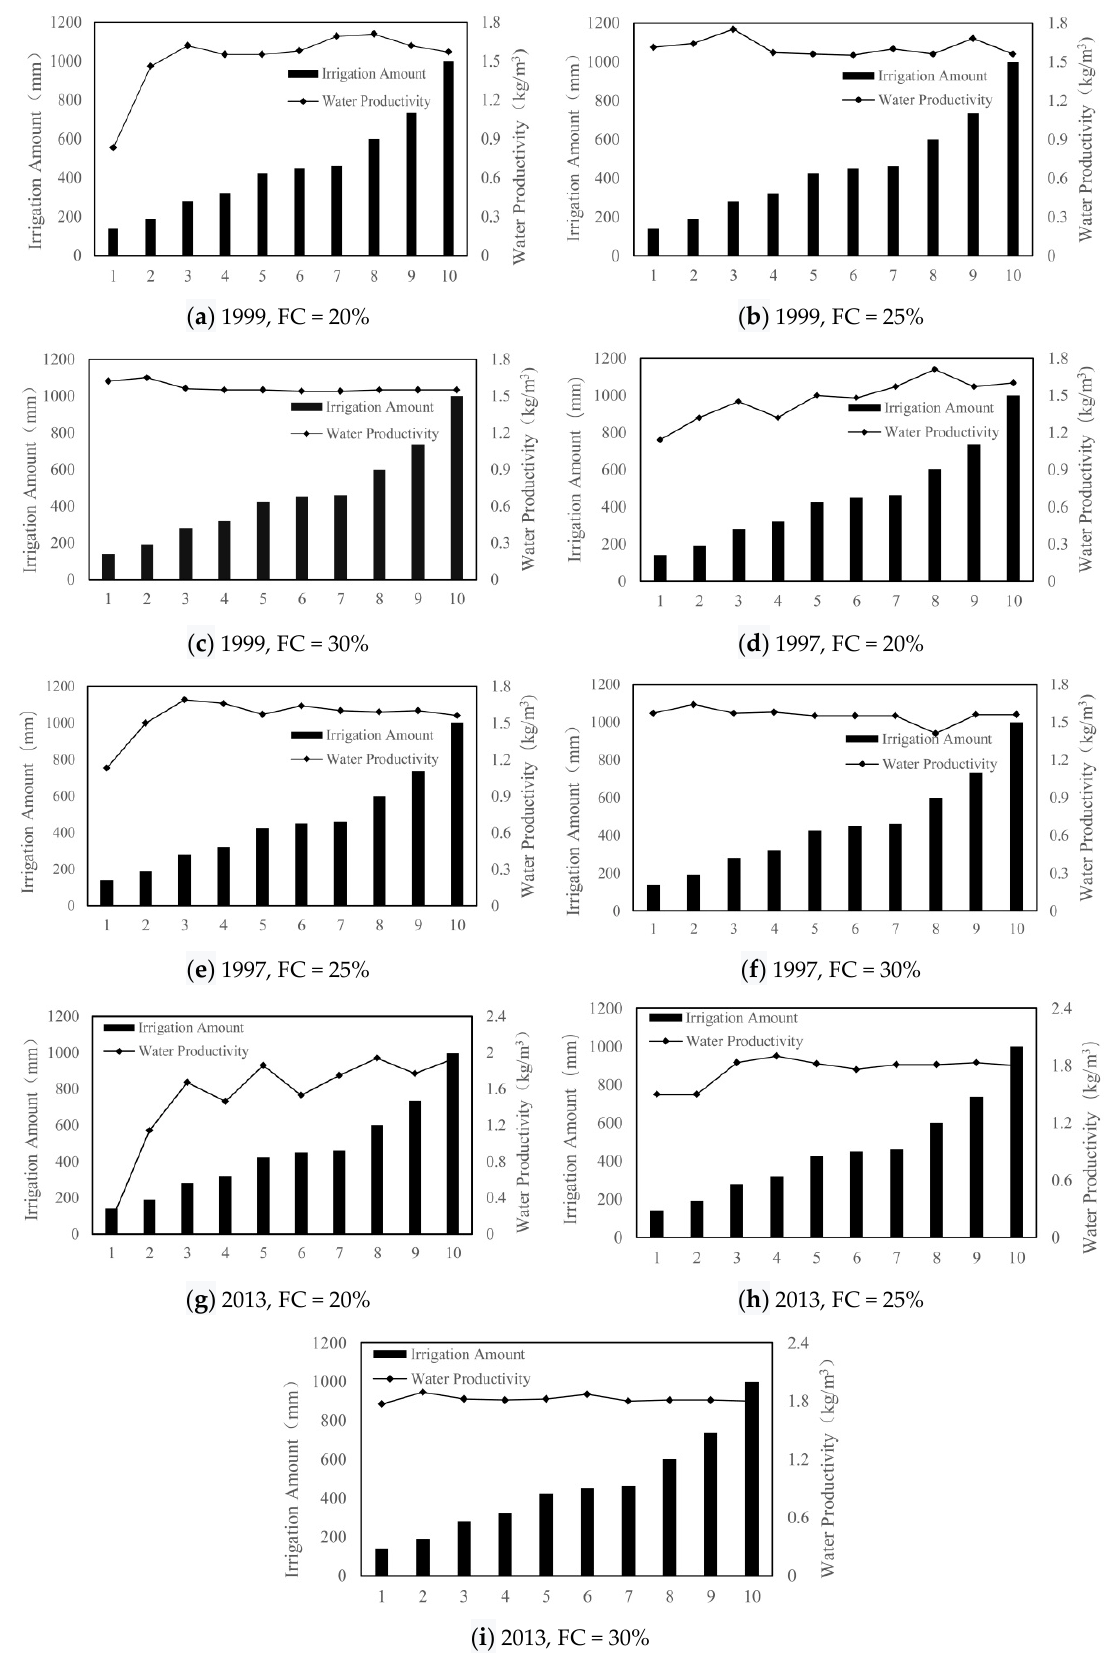
Figure 7. Water productivity (WP) map.